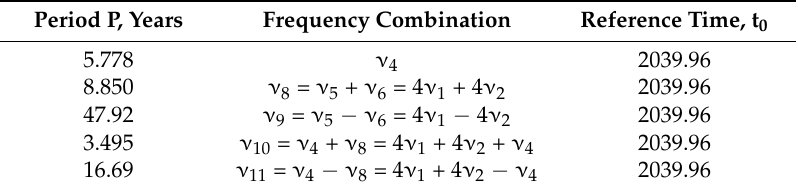
Table 3. The 5.778-year component and additional components generated by frequency combination from Table 1 components. The latter four are generated from both zonal and meridional component frequencies.